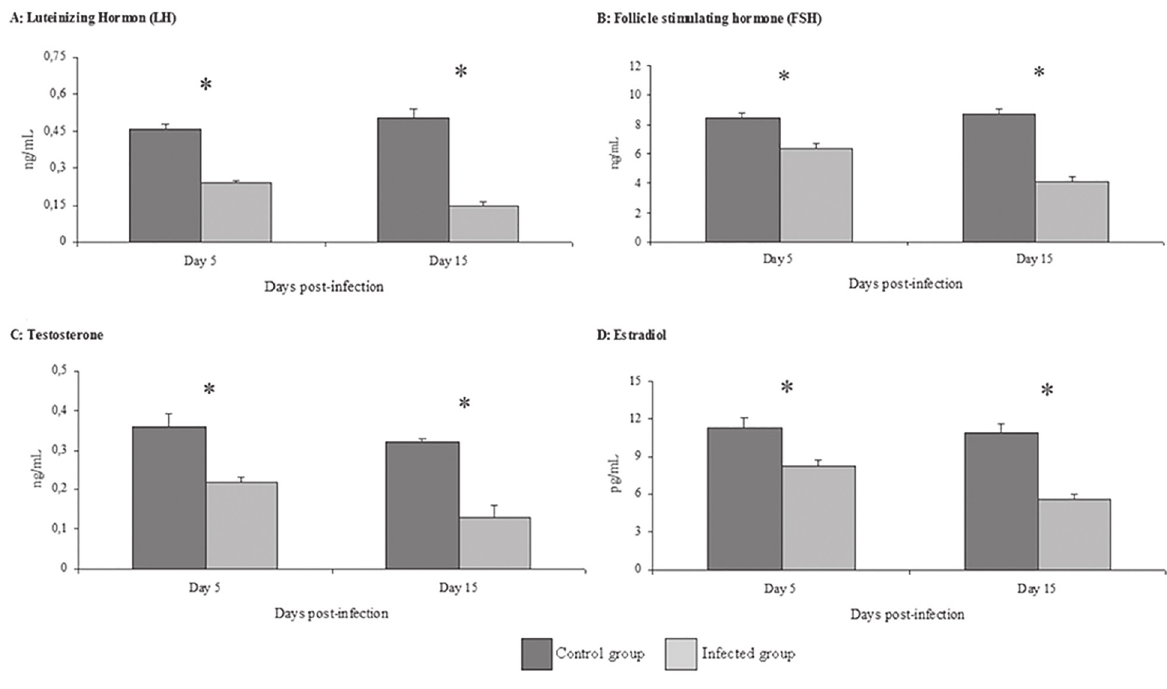
Figure 1 - Serum levels of luteinizing hormone (A), follicle stimulating hormone (B), testosterone (C) and estradiol (D) in rats experimentally infected with Trypanosoma evansi on days 5 and 15 PI compared to uninfected animals (Student: * P